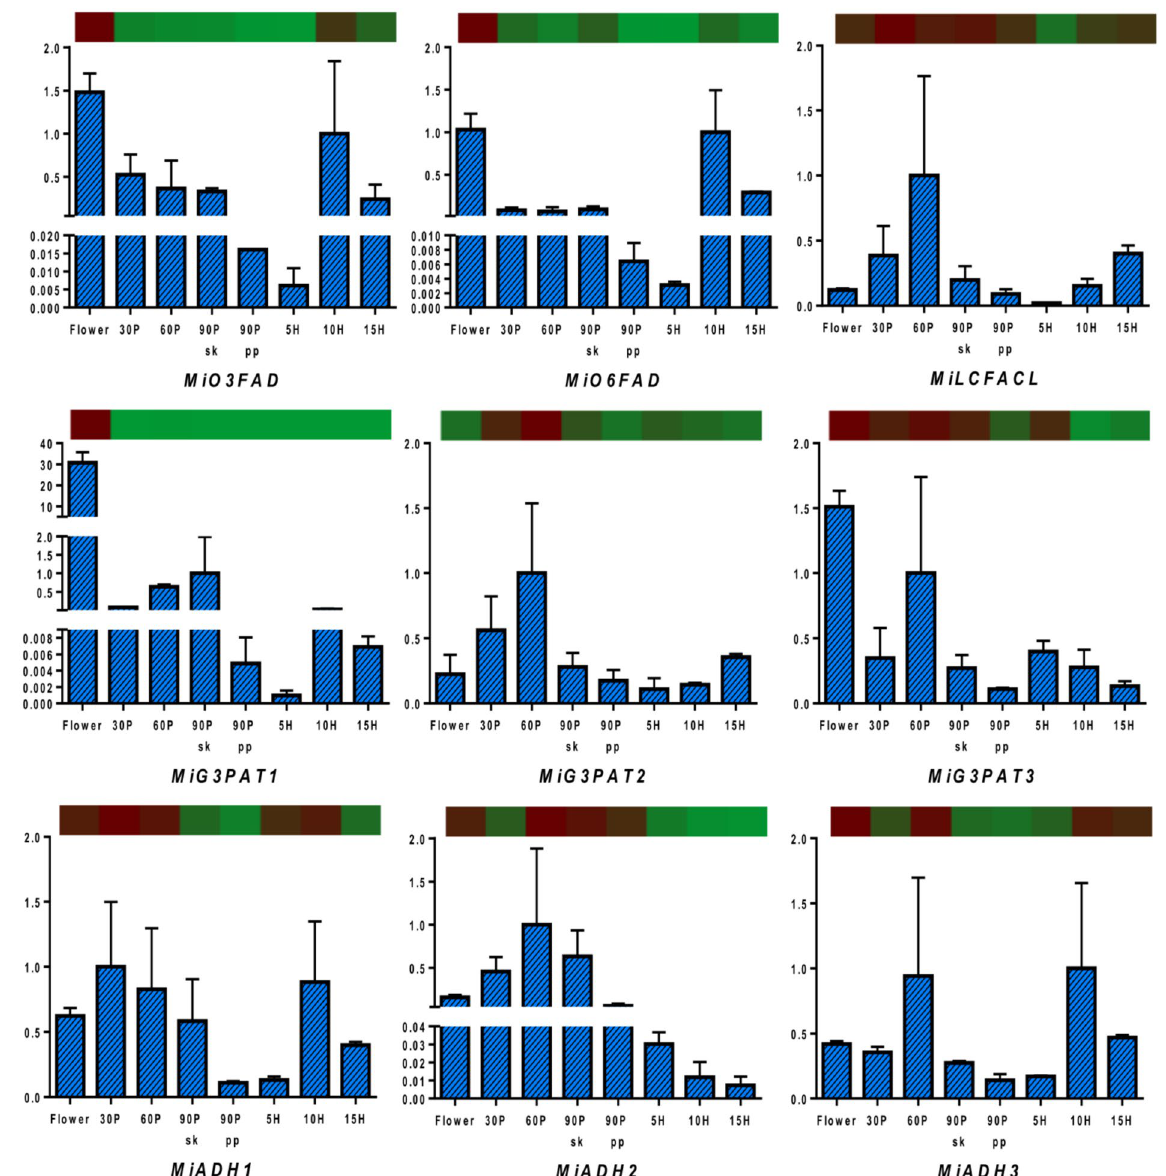
Figure 6. Quantitative reverse-transcriptase PCR validation of various transcripts obtained through RNAseq from lipid metabolism through various tissues (flower and fruit developing and ripening stages). Vertical bars at each data point represent standard error in the relative quantification among the three biological replicates. X-axis represents fruit development and ripening stages and Y-axis represents relative transcript abundance. The horizontal bar above each histogram represents the expression level of the same transcript as obtained through RNAseq analysis, wherein dark-red color indicates higher expression and light-green color indicates lower expression. Gene names are as referred in result section “Transcriptome validation through qRT